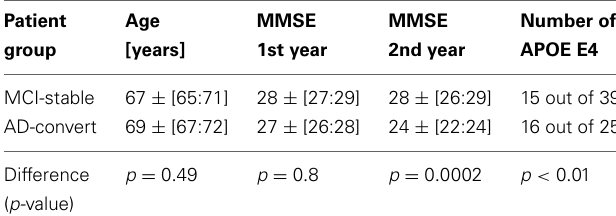
Table 2 | Overview of patient